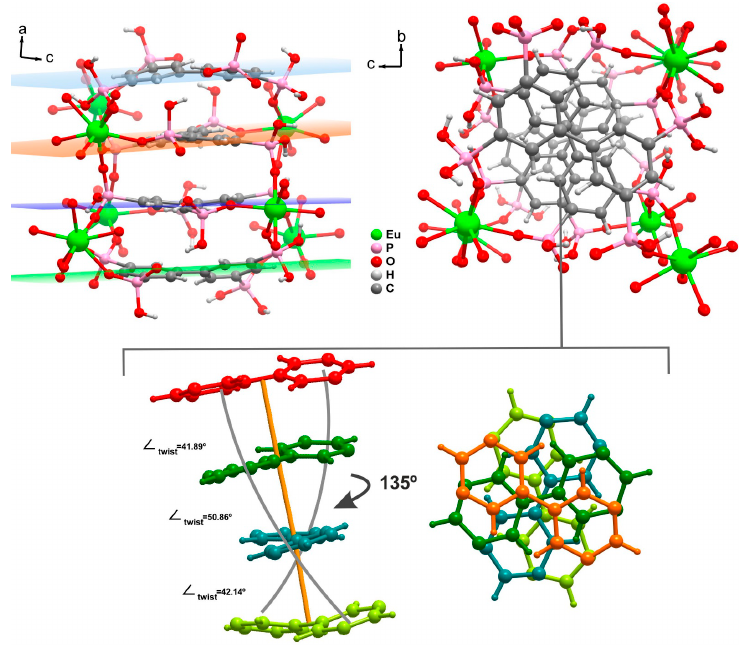
Figure 3. Schematic representation of the organic cylinder present in the crystal structure of [Eu 7 (H 5 btp) 4 (H 5.5 btp) 2 (H 6 btp) 2 (H 2 O) 12 ] ∙ 23.5H 2 O ∙ MeOH ( 1Eu ) viewed along the [010] and [100] directions of the unit cell. The schemes emphasize the close packing of the organic linkers, with inter-planar distances ranging between 3.5805(4) and 3.8321(5) Å. On the right there is a representation of the same organic skeleton in the cylinder emphasizing the close packing and rotation along the a -axis of the four composing aromatic cores.